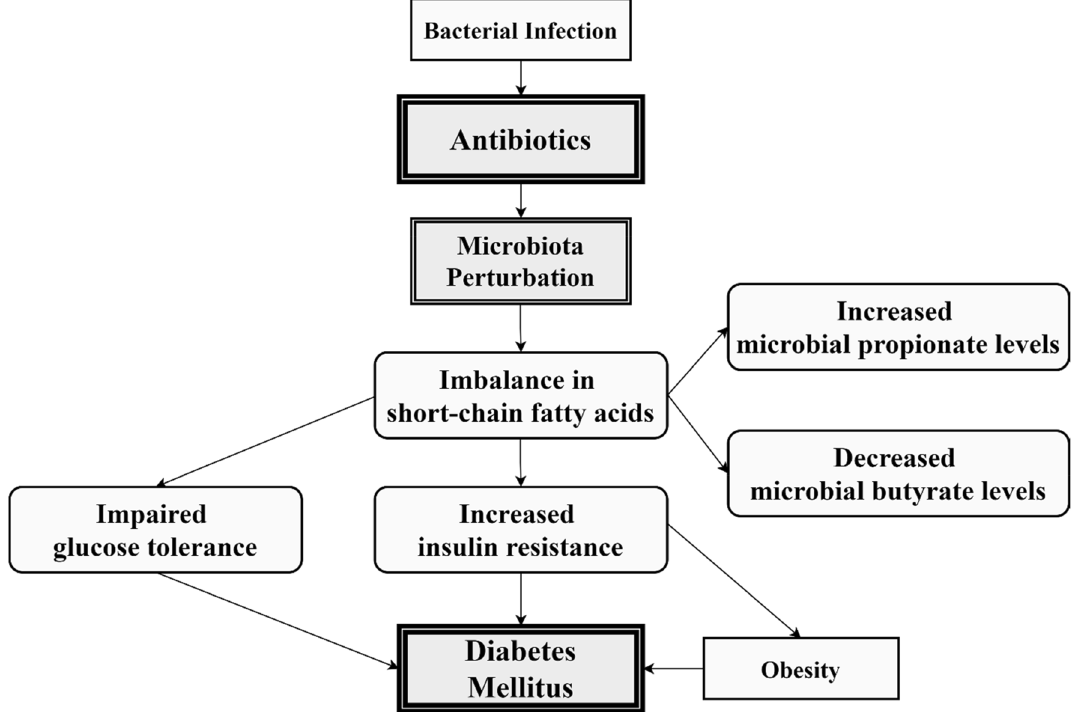
Figure 2. Potential hypotheses regarding relationship between antibiotics use and increased risk of